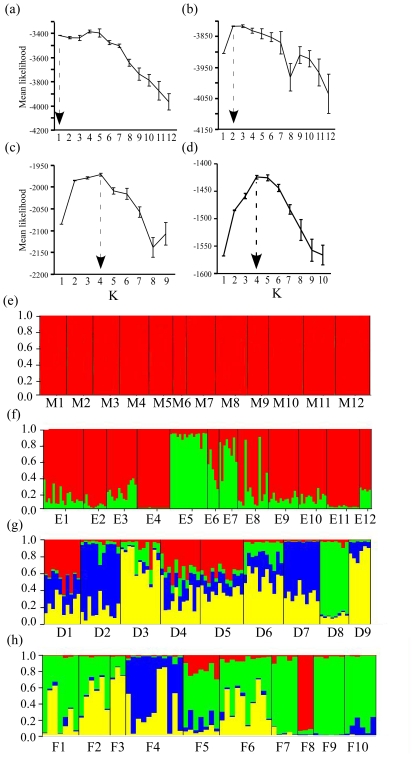
Population structure within four sites differing in arrival time.
structure
[41] analyses show mean (±SE) likelihood at each K over 10 runs, and dotted arrows show the probable true value of K for each group of locations: (A) Miami, (B) Everglades, (C) Forst De Soto, and (D) F.I.T. Proportional membership of each individual gecko (thin vertical line) to each cluster, represented by different colors, for all four sites: (E) Miami, (F) Everglades, (G) Fort De Soto, and (H) F.I.T. Black vertical lines separate individuals by buildings indicated below each group.